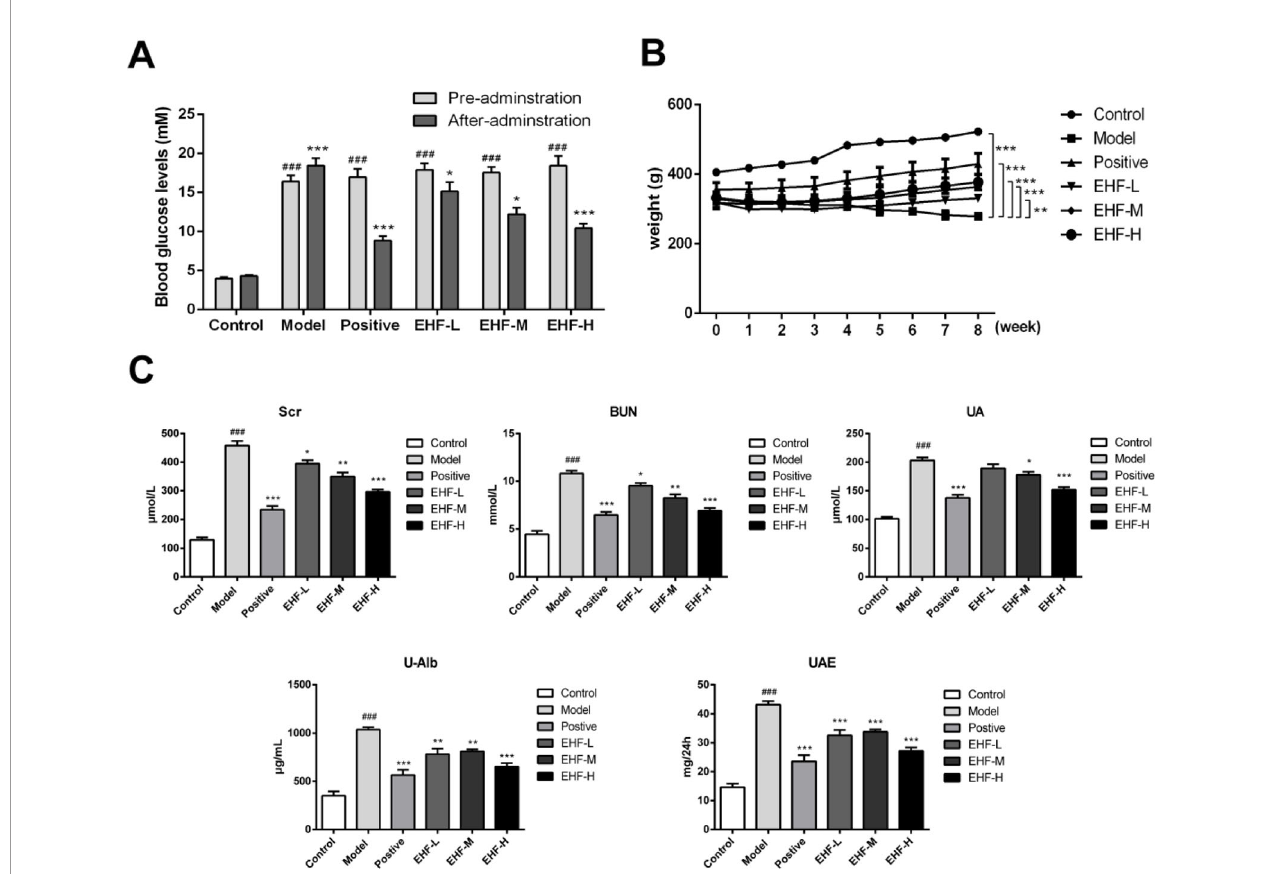
FIGURE 1 | EHF improved the biochemical parameters in DN rats. (A) The blood glucose was measured pre- and after-administration EHF. *p < 0.05, ***p < 0.001 versus pre-administration, ### p < 0.001 versus control group. (B) The weight of rats in each group. **p < 0.01, ***p < 0.001 versus model group. (C) The level of Scr, BUN, UA, U-Alb and UAE in each group was determined by automatic biochemical analyzer. *p < 0.05, **p < 0.01, ***p < 0.001 versus model group, ### p < 0.001 versus control group. n =